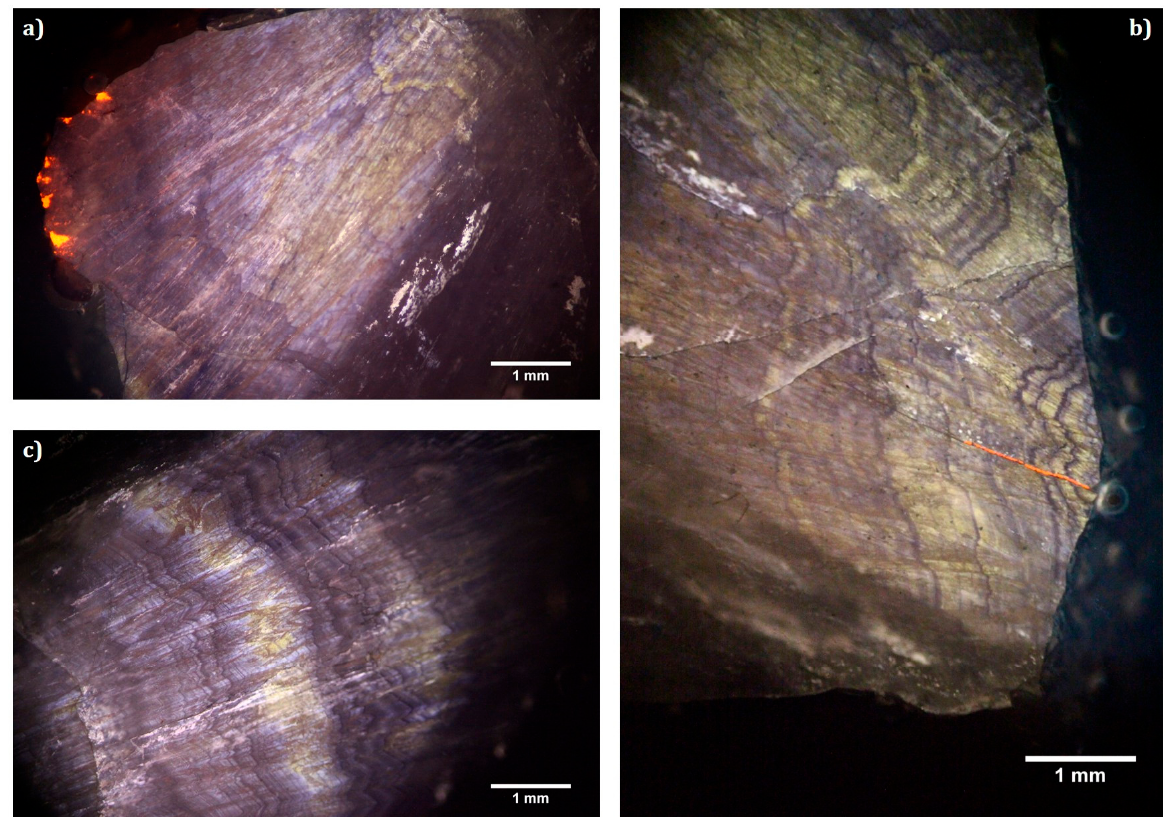
Figure 3. Cathodoluminescence images ( a – c ) obtained in different areas by OM-CL of La Sassa quartz polished section. The red-orange luminescent spots ( a ) and veins ( b ) are